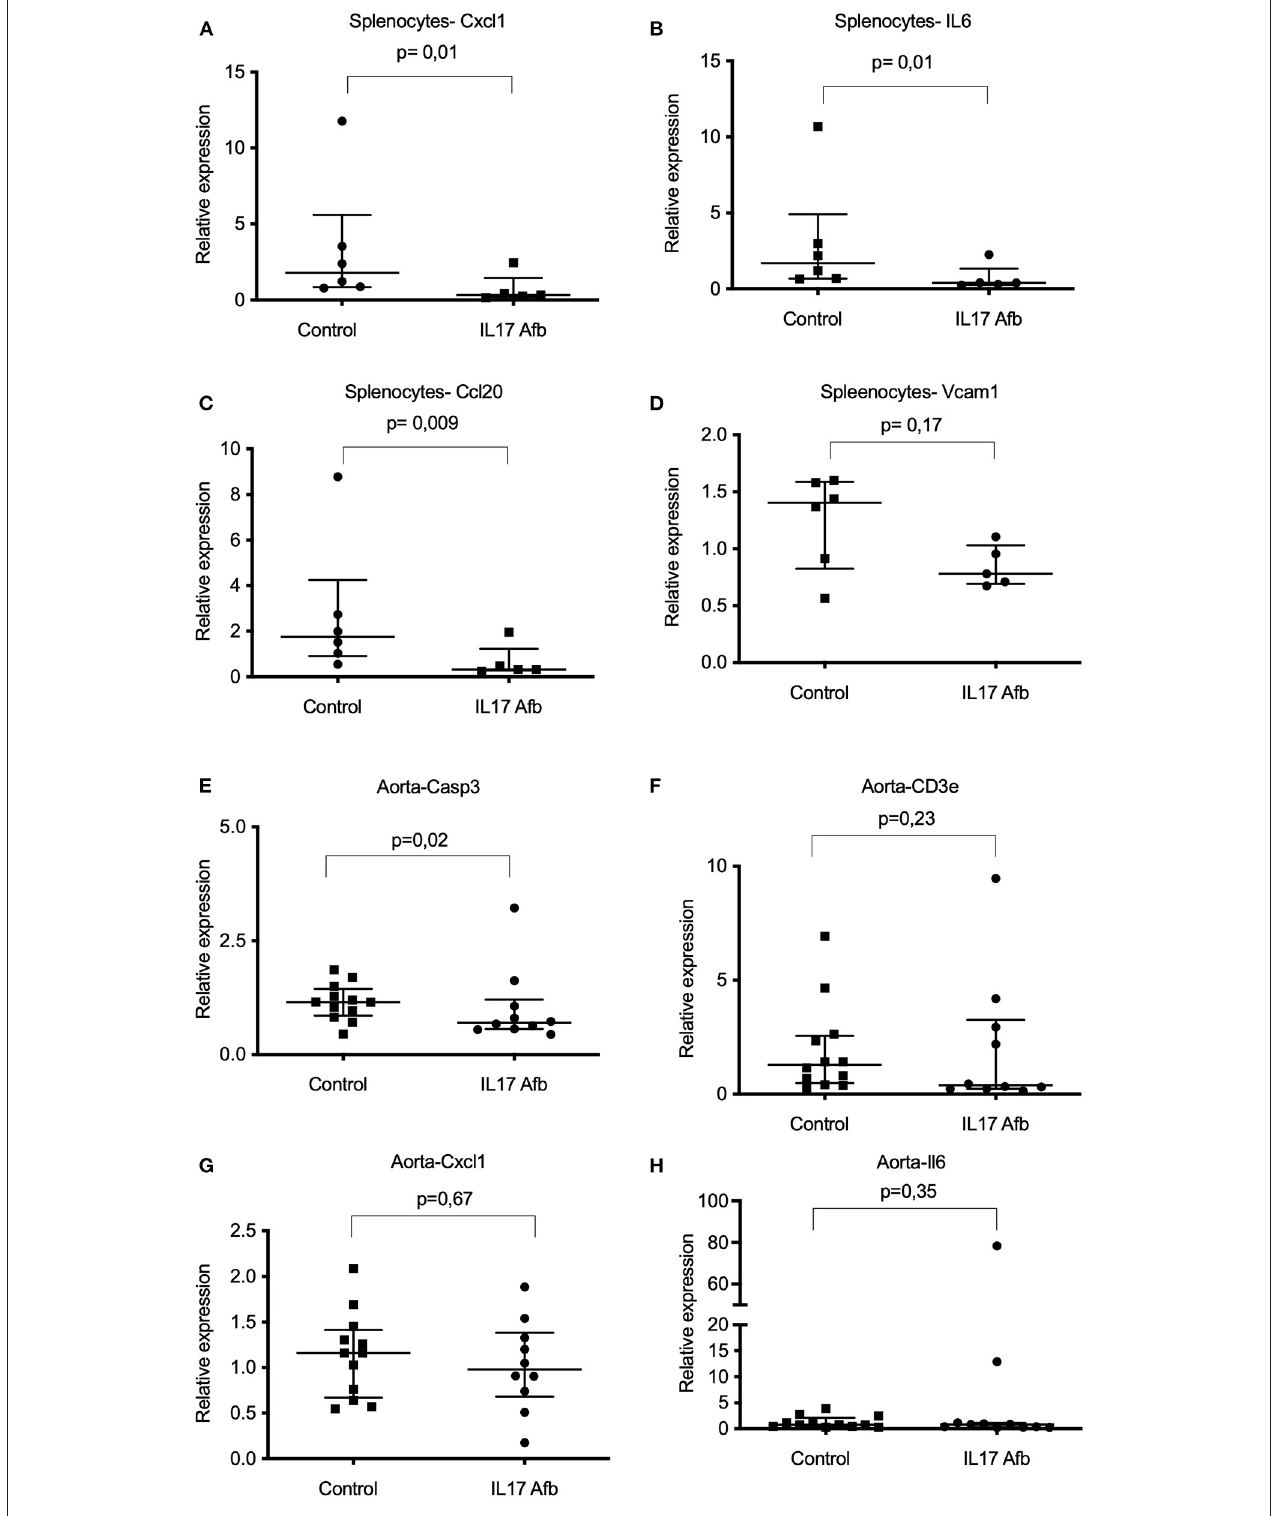
FIGURE 4 | Effects of Affibody molecule against IL17A on gene expression in splenocytes and thoracic aorta from ApoE − / − mice. mRNA levels were assessed by quantitative real-time reverse transcription polymerase chain reaction (qPCR) analysis. Analysis of Cxcl1, Il6, Ccl20, and Vcam1 genes in splenocytes from sham ( n = 6) and α IL17A Affibody molecule treated mice ( n = 5) (A-D) . Analysis of Casp3, Cd3e Cxcl1, and Il6 transcripts in the thoracic aorta from sham ( n = 12) and α IL17A Affibody molecules treated mice ( n = 10-11) (E-H) . Data are presented as Median with IQR. NS, Not significant.